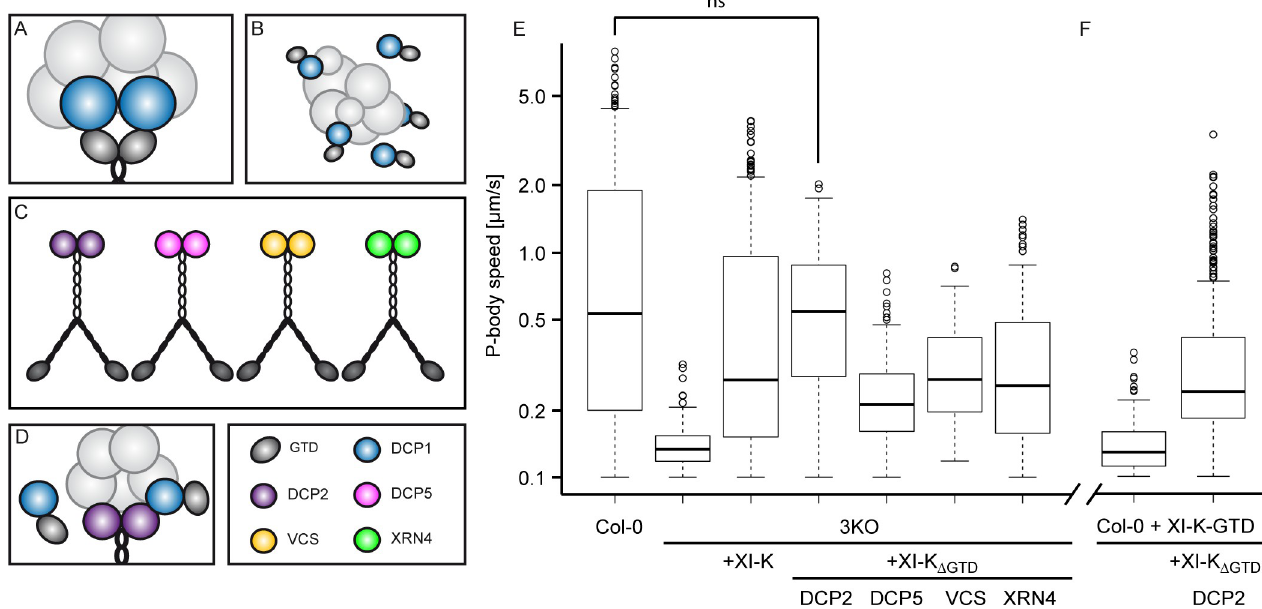
Fig 9. Direct target binding of myosins to test the dominant negative GTD function. (A) P-body binding to class XI myosins is mediated by DCP1 [28]. (B) DCP1 is blocked by free GTDs on P-bodies or in the cytoplasm. (C) The GTD of a full-length genomic myosin XI-K construct under the endogenous promoter [48] was exchanged with the ORF of P-body core components. (D) XI-K Δ GTD -DCP2 can bind and move P-bodies in presence of free GTDs. (E), (F) Boxplot of P-body speed data collected by manual tracking of DCP1-CFP marked P-bodies in transiently transformed cells. Significance was determined by a two-sample Wilcoxon test at p < 0.001, p < 0.01, and p < 0.05 (S3 Table).